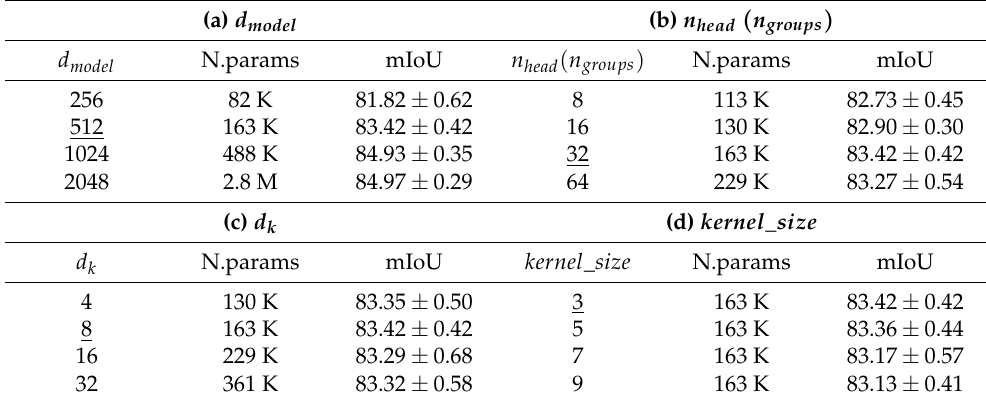
Table 5. The influence of four hyperparameters of GL-TAE on the performance of TiSeLaC. ’Underlines’ are default parameter values.